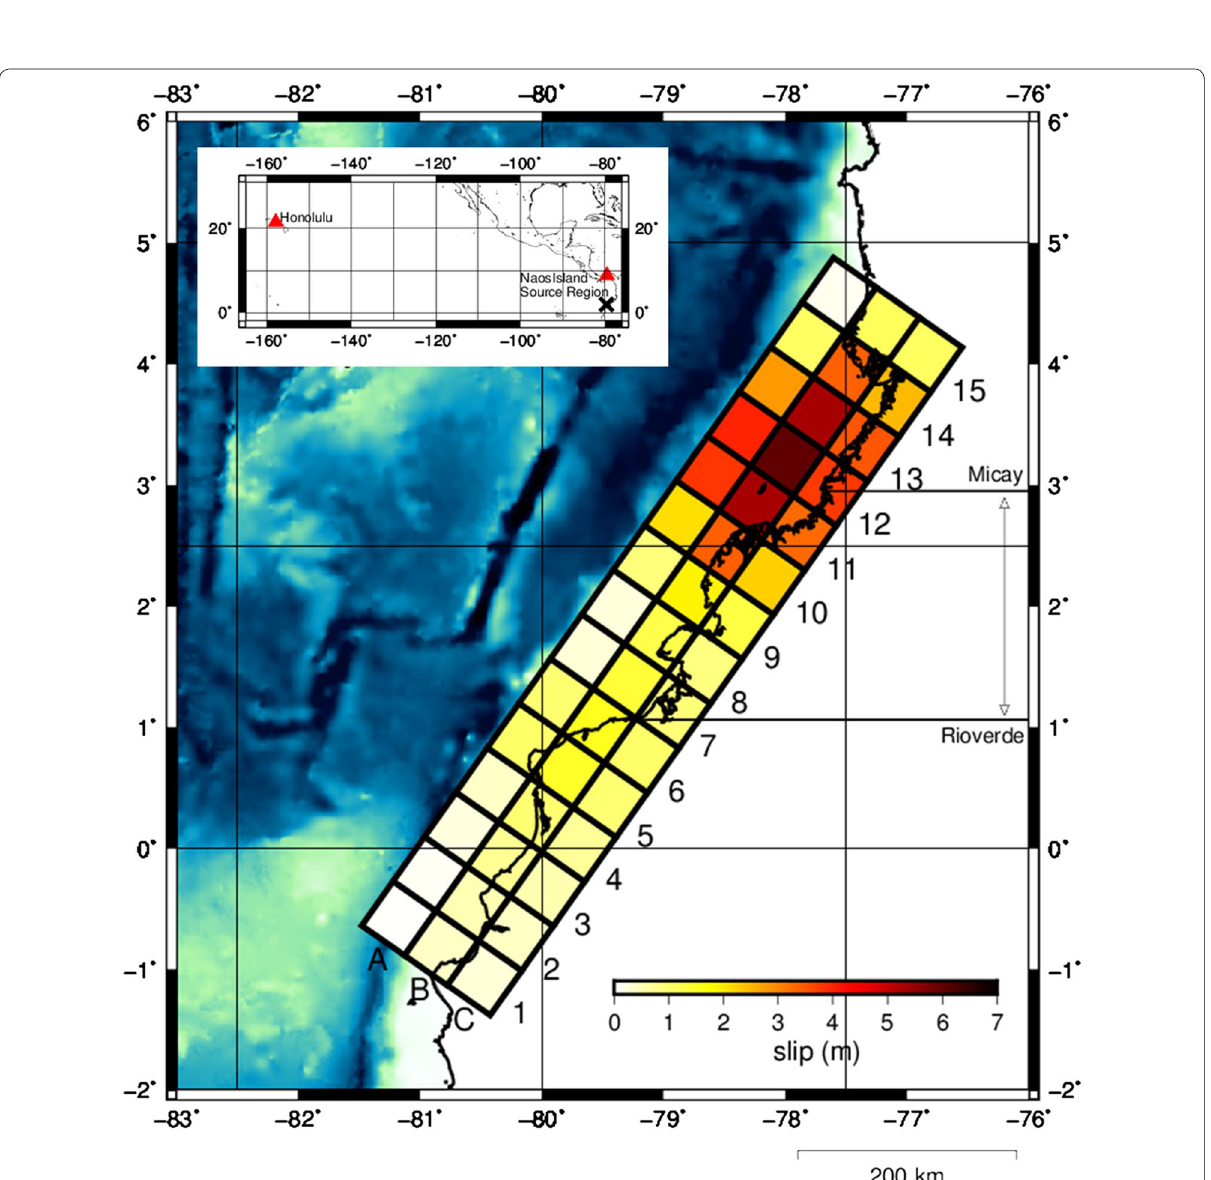
Fig. 1 Location map for the 1906 earthquake, tide gauge stations, and assumed source region. The color scale shows the slip amount estimated by the inverse analysis using the observed tsunami